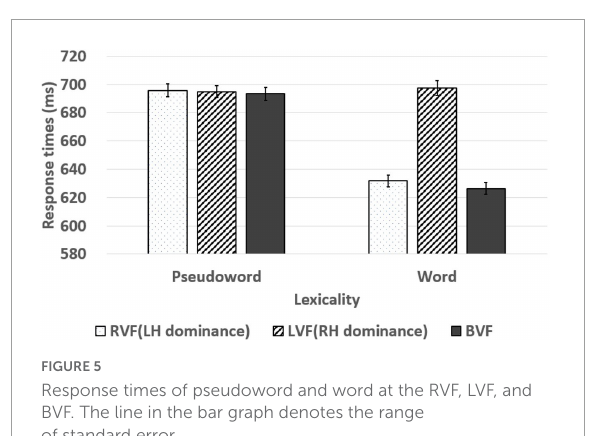
FIGURE5 Response times of pseudoword and word at the RVF, LVF, and BVF. The line in the bar graph denotes the range of standard